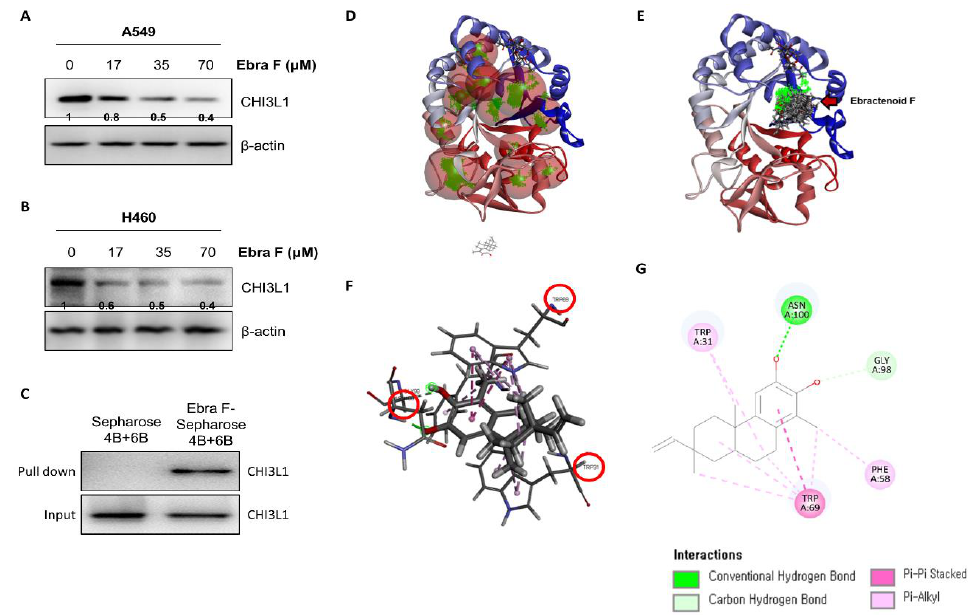
Figure 5. Interaction and molecular binding between ebractenoid F and CHI3L1. Differences in the expression levels of CHI3L1 in lung cancer cells after treatment with different concentrations of ebractenoid F ( A , B ). Pull-down assay showing the interaction between ebractenoid F and CHI3L1 ( C ). Ebractenoid F was conjugated with epoxy-activated Sepharose 4B and 6B. The part marked with red spheres: 1 to 12 cavities of CHI3L1 are represented ( D ). Docking model of ebractenoid F with CHI3L1. Ebractenoid F could be docked in these 12 cavities with the highest binding potential, and docking was possible with 14 different forms ( E ). Receptor–ligand interaction: 3D model ( F ). The binding energy delta G of the most energetically stable model among the 14 docking forms of ebractenoid F was calculated to be − 7.66 kcal/mol. Receptor–ligand interaction: 2D model ( G ). The amino acids that play an important role in the binding of this docking are tryptophan31, tryptophan69, phenylalanine58, asparagine100, and